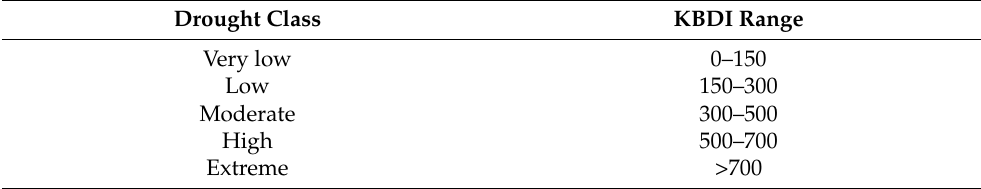
Table 3. Keetch–Byram drought index ( KBDI ) drought